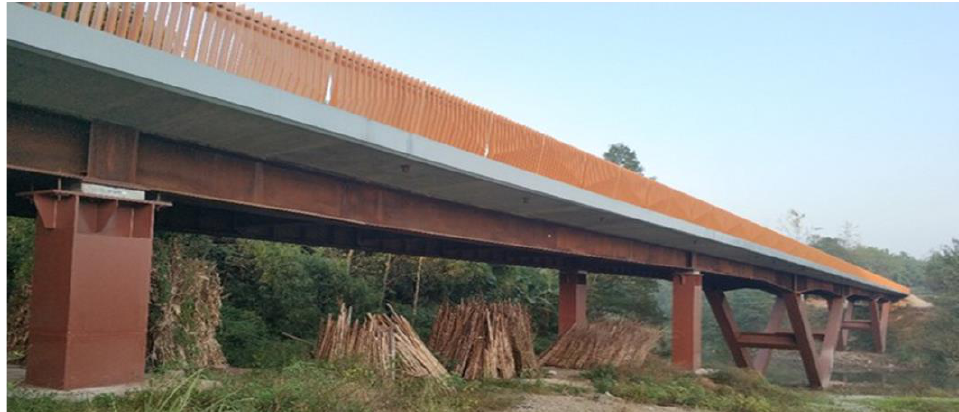
Figure 3. Elevation of the whole bridge.